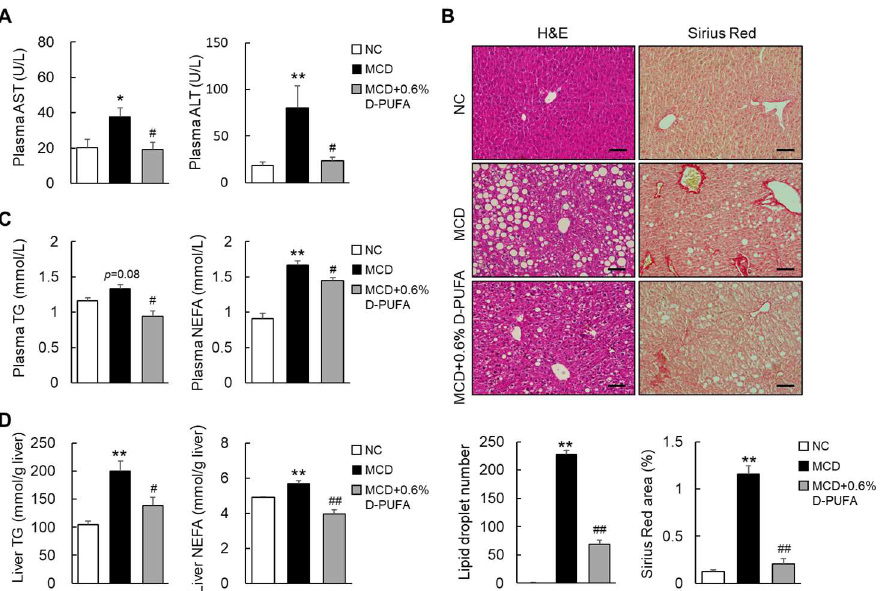
Figure 3. D-PUFAs prevent NASH progression in MCD mice. ( A ) Plasma levels of AST and ALT. ( B ) Representative photographs of H&E and Sirius Red staining of liver sections. Scale bars = 100 µ m. ( C ) Plasma levels of TG and NEFA. ( D ) Levels of hepatic TG and NEFA contents. Data are presented as means ± SEM, n = 5–6. * p < 0.05, ** p < 0.01 vs. NC; # p < 0.05, ## p < 0.01 vs. MCD. Significance